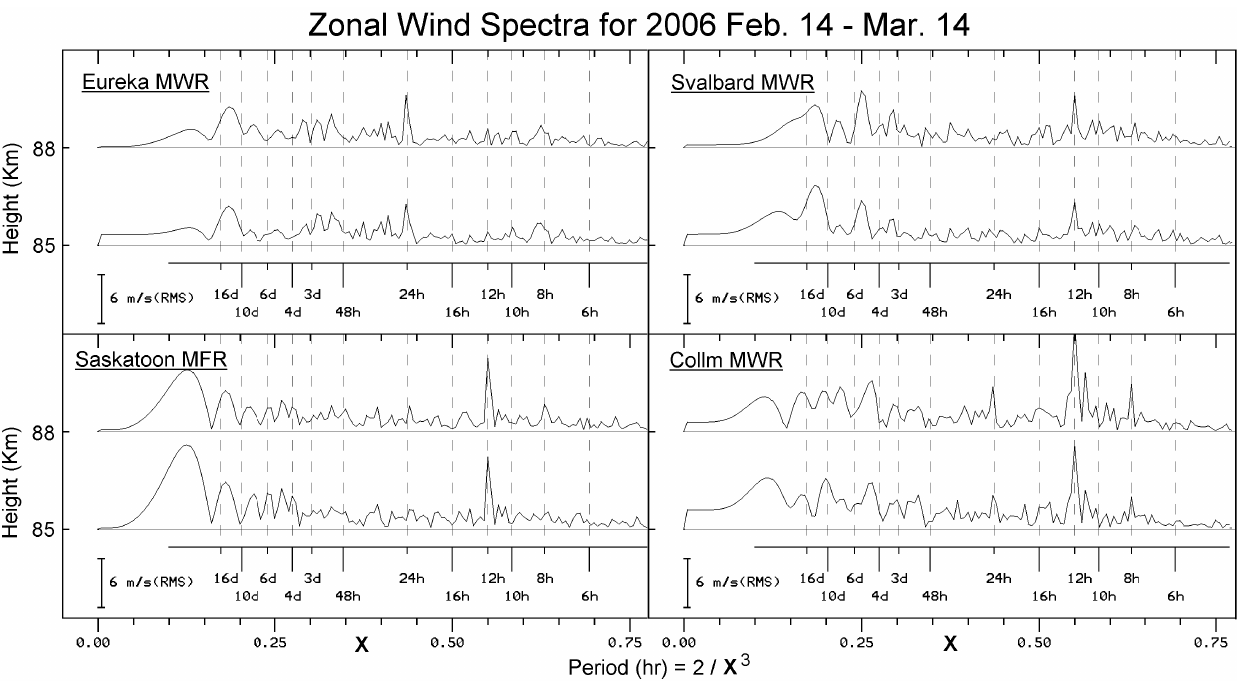
Fig. 1. Frequency spectra for two Arctic and two high mid-latitude radar-locations during winter months. The ordinate axis parameter is X, where the Period (h)=2/X 3 =1/f, where f is the frequency in cycles per hour. This choice is discussed in the text, and provides better apparent resolution and easier perusal in the range of periods that are of